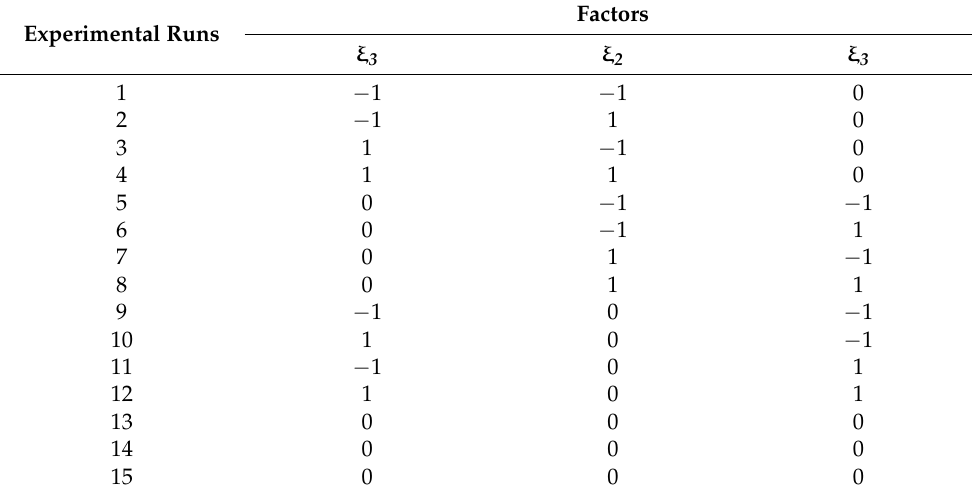
Table 2. Box–Behnken design model for factorial design of phenol adsorption experiments optimization. Experimental